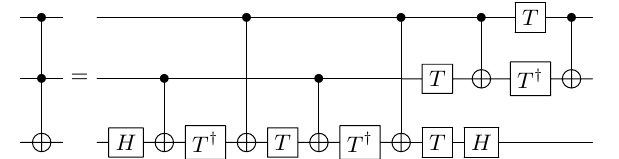
Figure 2. Compiled quantum order-finding routine for N 3 for the control register and 2 for the work register. The above circuit determines 2 n s / r to three bits of accuracy, from which the order can be extracted. Here, up to a global phase, S gates,